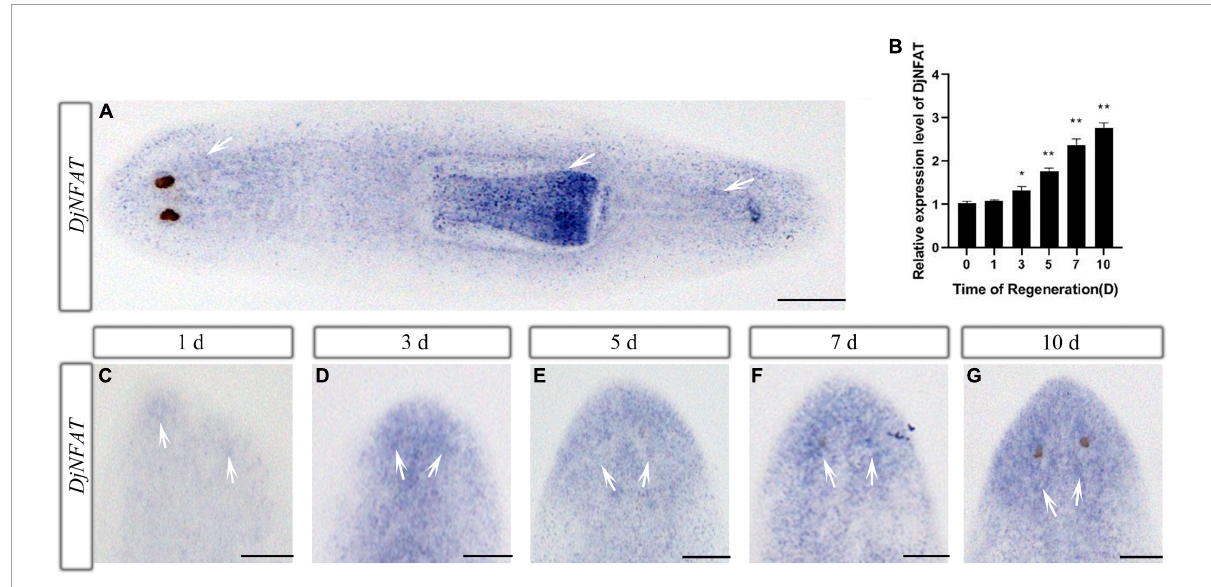
FIGURE5 Expression patterns of DjNFAT in the intact and regenerating planarians after decapitation. (A) Dorsal view of an intact planarian shows an abundant expression in the pharynx and parenchymal cell (arrows). (B) qPCR analysis of DjNFAT expressions in the regenerating fragments at 0, 1, 3, 5, 7, and 10 days during planarian head regeneration, n = 4, * P < 0.05, ** P < 0.01. d, day. (C–G) WISH showing the expressions of DjNFAT in regenerating planarians at 1, 3, 5, 7, and 10 days during planarian head regeneration (arrows), n = 6. Scale bars: 0.5 mm.